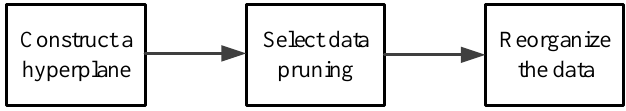
Figure 3. Selective Support Vector Machine data processing flow chart.